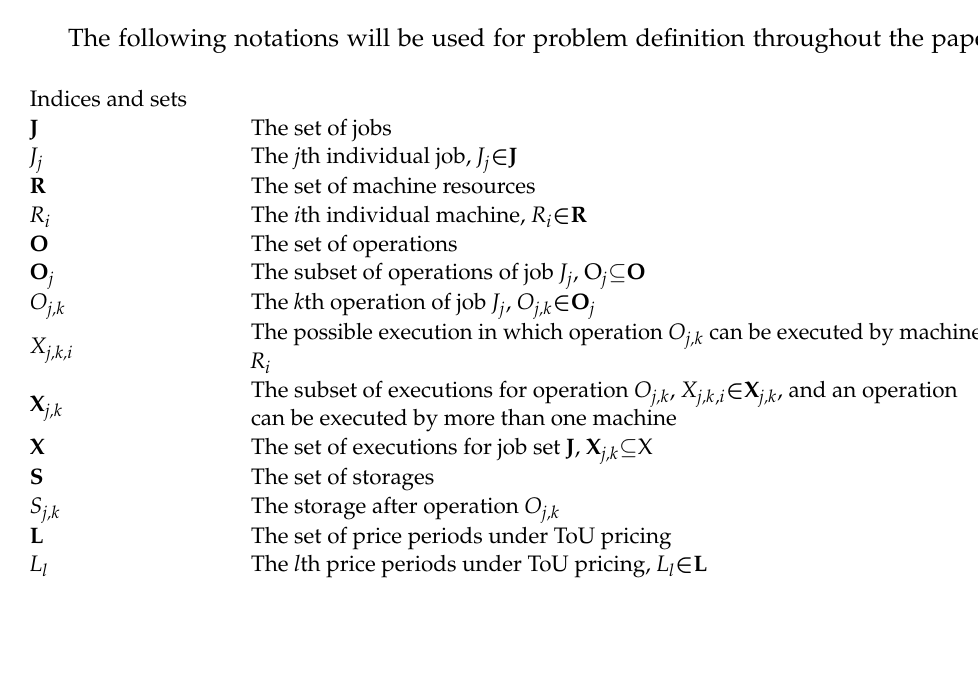
Figure 1. Diagram of a flexible manufacturing system with storage between two operations.